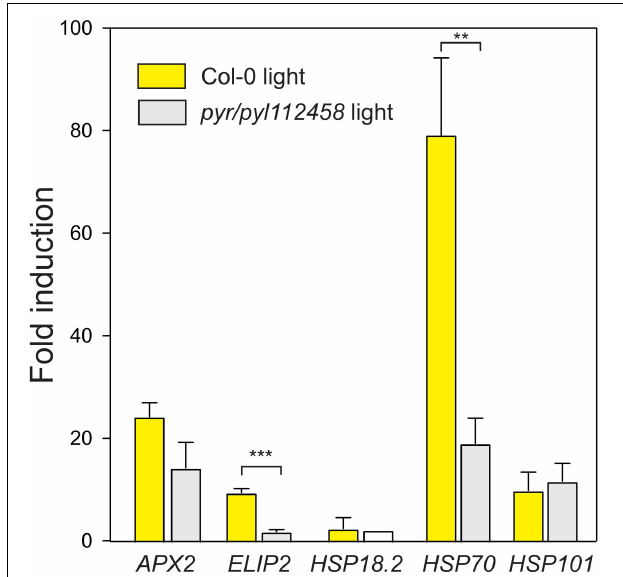
FIGURE 4 | Fold induction of HL and heat stress marker genes after 1 h HL in Col-0 and pyr/pyl112458 (growth condition Turku, Table 1 ). The average of three biological replicates are shown; error bars depict standard deviation. The t -test was used for statistical analysis and depicts significant differences between Col-0 and pyr/pyl112458 (** P < 0.01; *** P <